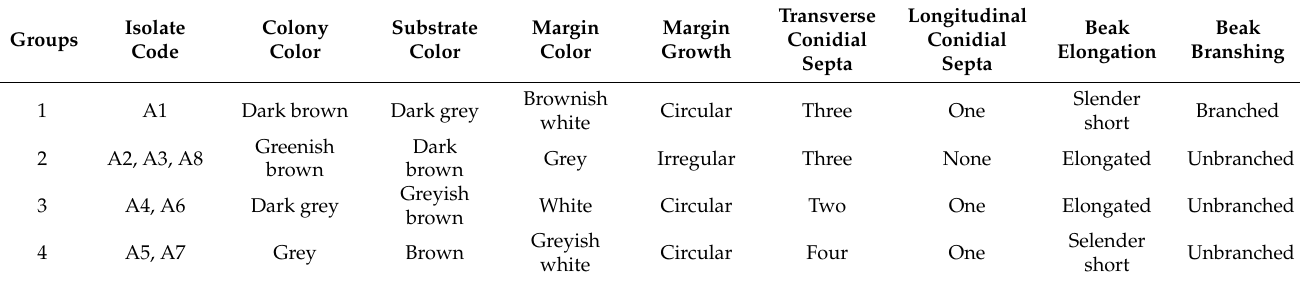
Table 1. Morphological variability of Alternaria solani isolates.